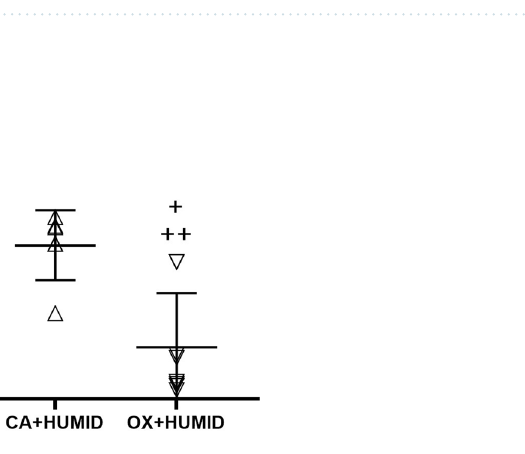
Figure 5. Exhaled nitric oxide (ppb) ( A ) and oxidative stress in the nasal lavage fluid ( B ). + P < 0.05 compared to CA + DRY group. ++ P < 0.05 compared to CA + HUMID group.